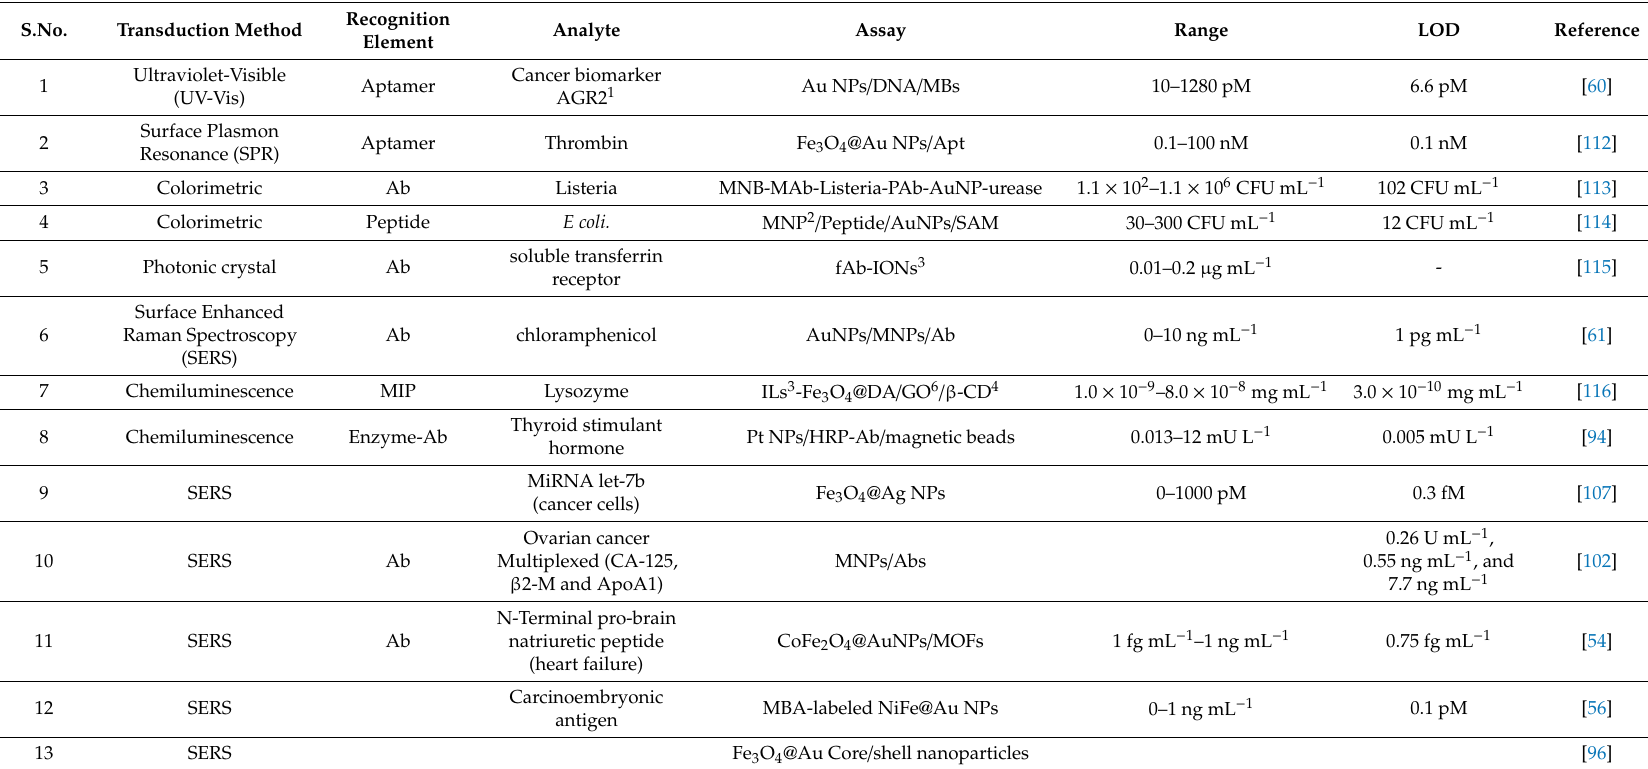
Table 2. Magnetic nanoparticle (MNP)-based optical sensors for the detection of various analytes.